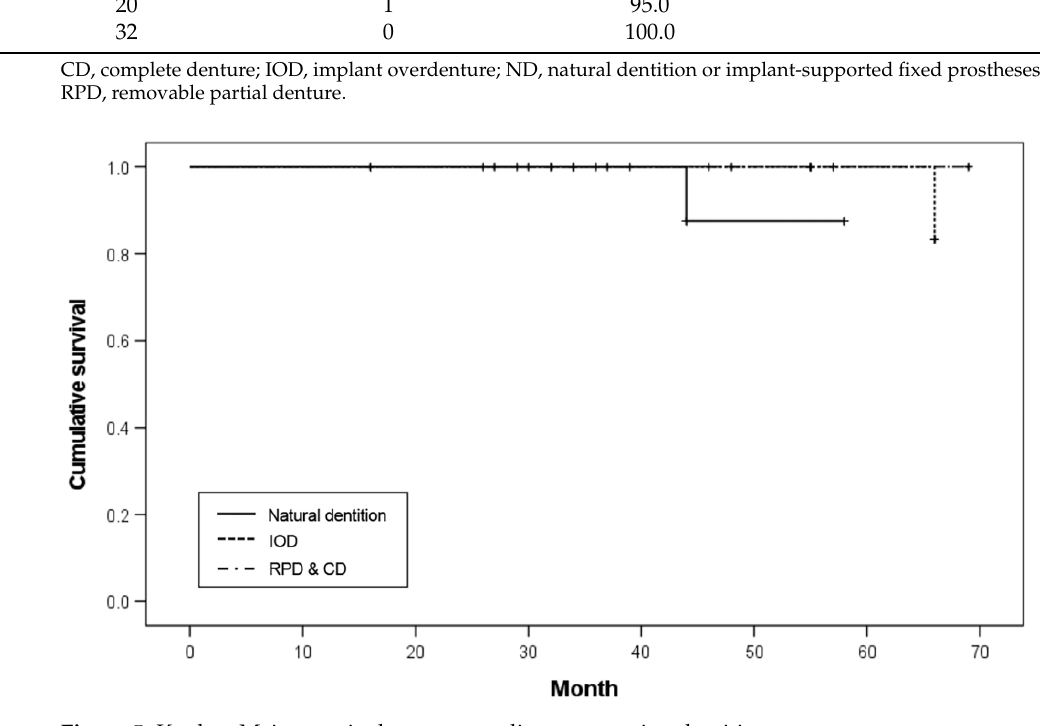
Figure 5. Kaplan–Meier survival curve according to opposing dentition. Table 7. Marginal bone loss of implants